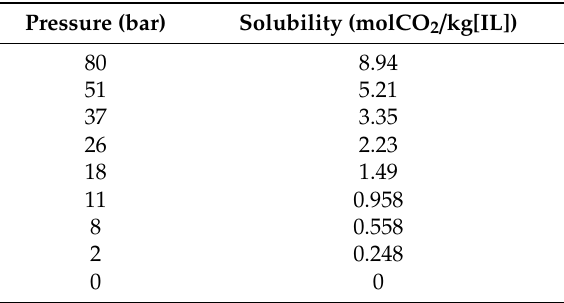
Table 5. Solubility data of CO 2 in the ionic liquid [hmim][Tf2N] at 298.1 K [37]. Pressure